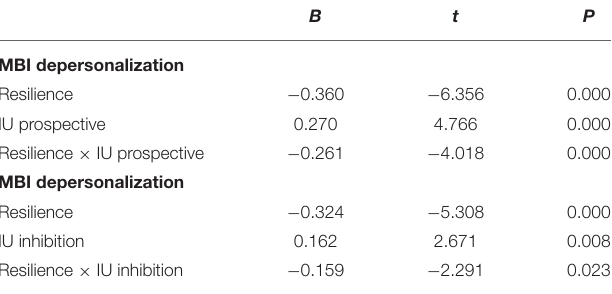
TABLE 7 | General linear models: principal and interactive effects of resilience and intolerance of uncertainty (factor scores) on MBI depersonalization. B t